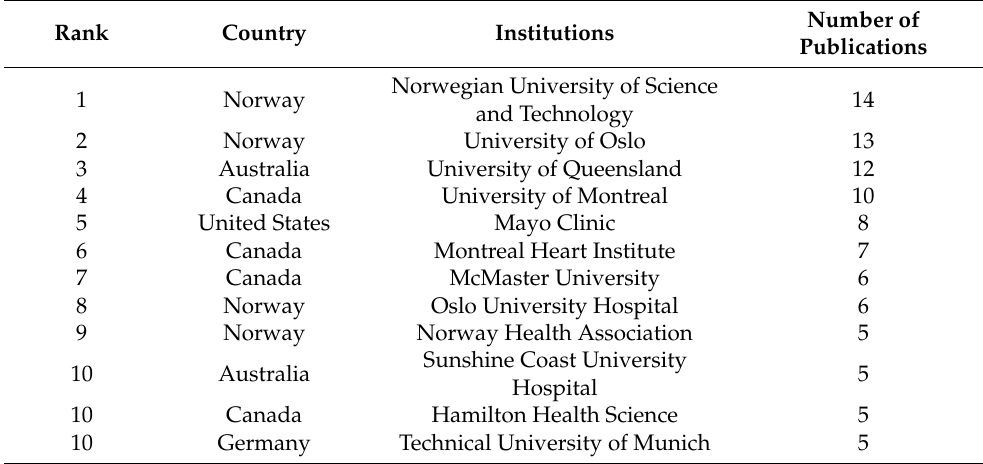
Table 5. Top 10 institutions in terms of number of articles issued.